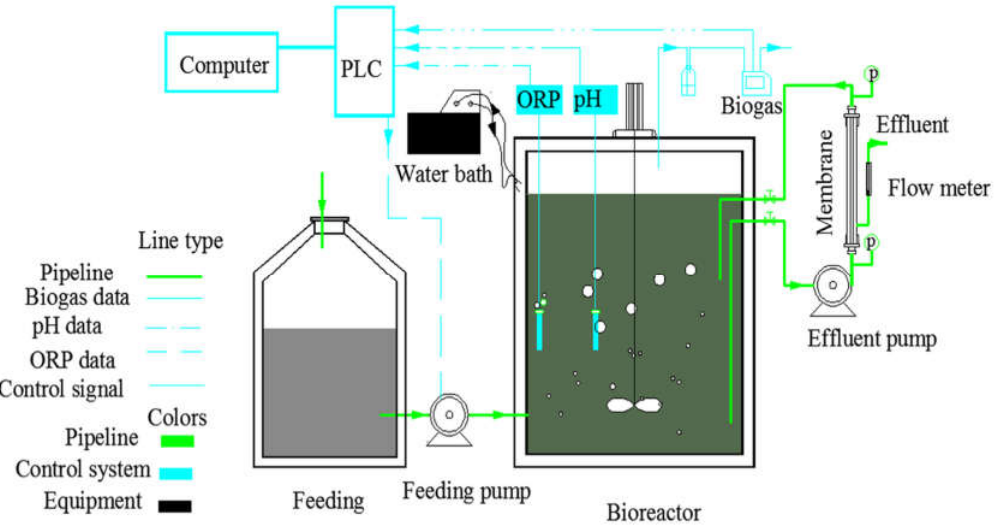
Figure 1. Diagram of the lab scale side-stream anaerobic membrane bioreactor (AnMBR). ORP, oxidation reduction potential; p: pressure gauge; PLC, programmable logic controller.